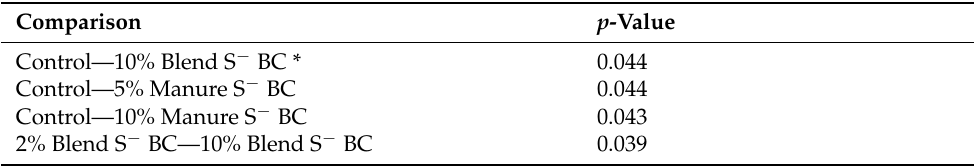
Table 3. p -values for Trifolium incarnatum root dry weights.